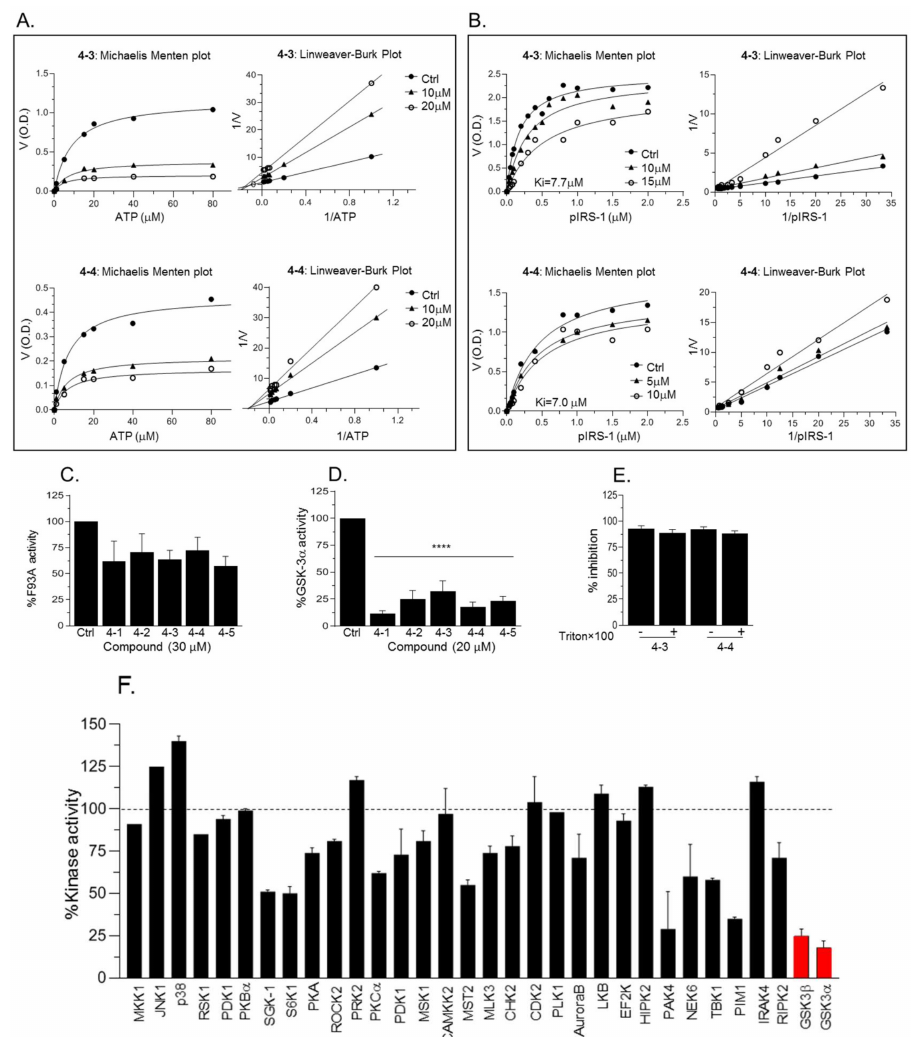
Figure 6. Kinetic analysis of new compounds. ( A ) Michaelis Menten plots of ATP competitive assays with 4-3 and 4-4. The corresponding Lineaver–Burk plots are shown at the right panel. ( B ) Michaelis Menten plots of substrate competitive assays with 4-3 and 4-4. The corresponding Lineaver–Burk plots are shown at the right panel. ( C ) In vitro kinase assays of F93A mutant in the presence of 4-1 through 4-5 (20 µ M each). Results are mean of three independent experiments ± SEM using one-way ANOVA with Dunnett’s post hoc test. ( D ) GSK-3 α kinase assays were performed with 4-1 through 4-5 (20 µ M each). Results the mean of three independent experiments ± SEM using one-way ANOVA with Dunnett’s post hoc test. **** p < 0.0001 treated vs. control. ( E ) GSK-3 β kinase assays were performed with 4-3 and 4-4 (20 µ M) in the presence of 0.05% Triton × 100. ( F ) Kinase assays were performed with a representative repertoire of protein kinases in the presence of 4-4 (10 µ M). Inhibition by 4-4 is presented as a percentage of kinase activity in the control assay with no inhibitor. Results are means ± SD of two independent experiments performed in duplicates. GSK-3 α / β are marked